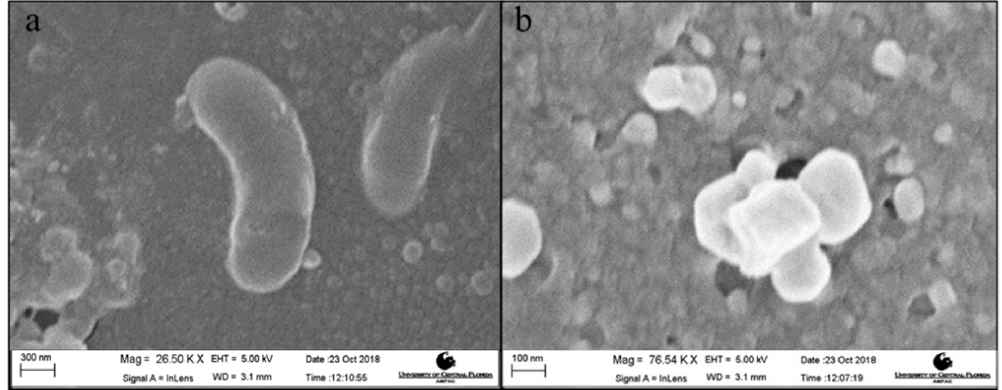
Figure 12. SEM images of membrane surface after 24 h exposure to E. coli : ( a ) virgin UF and ( b ) 5 AgPNP-BL UF membrane.